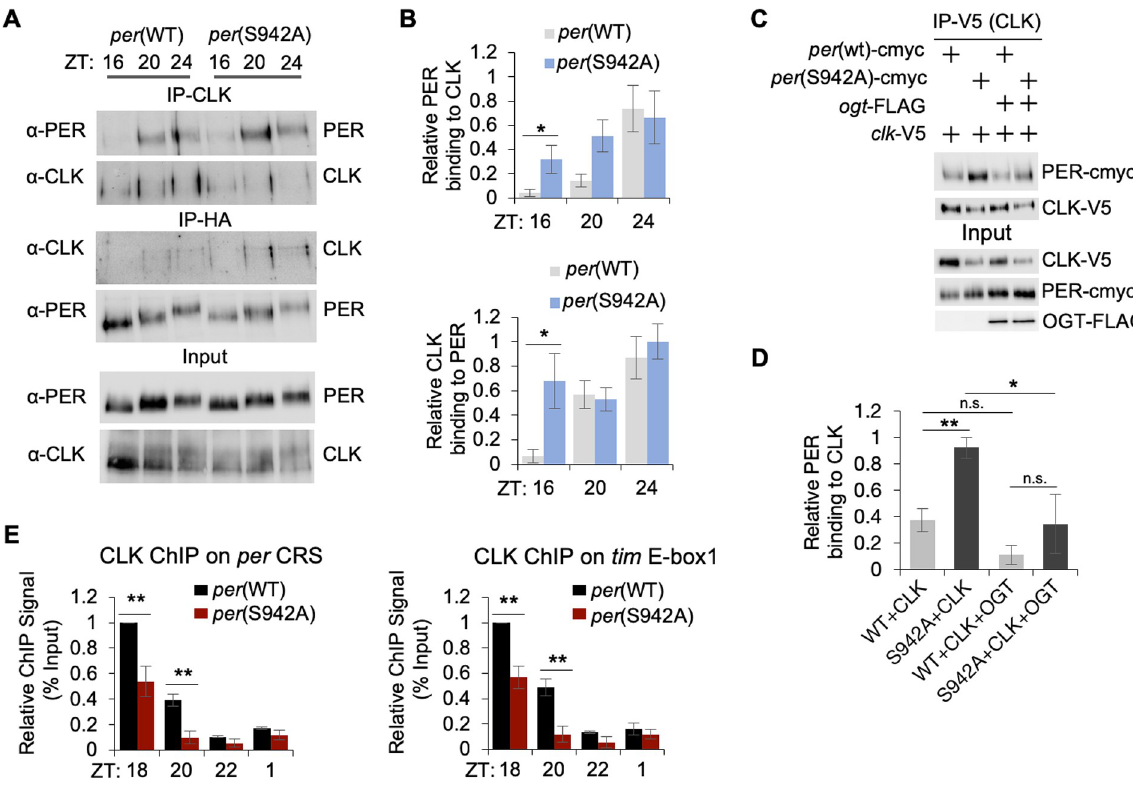
Fig 4. Non-O-GlcNAcylatable mutation at PER(S942) elevates PER repressor activity by increasing PER-CLK interaction and promoting CLK dissociation at circadian promoters. (A) Western blots showing reciprocal coimmunoprecipitations (coIPs) to examine PER-CLK binding in wper 0 ; p { per(WT)- HA10HIS} and wper 0 ; p { per(S942A)- HA10HIS} flies at the indicated time-points. Flies were entrained for 2 days in 12h:12h LD cycles and collected on LD3. Protein extracts from fly heads were directly analyzed (input) or immunoprecipitated with α -HA to detect PER-HA or α -CLK. Immune complexes were then subjected to immunoblotting to detect bait or interacting proteins. (B) Bar graphs showing quantification of reciprocal coIPs to examine PER-CLK binding from three biological replicates. Values for binding of interacting proteins are normalized to amount of bait detected in the IPs. Error bars indicate ± SEM. � P < 0.05. (C) Western blots showing results of coIP to evaluate PER-CLK interaction in S2 cells expressing pAc -per (WT)-6Xcmyc or pAc -per (S942A)-6Xcmyc with pAc -clk -V5 in the presence or absence of pMT -ogt -3XFLAG. Protein extracts from S2 cells were either directly analyzed by immunoblotting (input) or subjected to immunoprecipitation with α -V5 or resin conjugated with a non-specific antibody ( α -HA) as negative control (no signal detected). Immune complexes were analyzed by α -V5 to detect CLK-V5 protein (bait) or by α -cmyc to assess interaction with PER-cmyc. (D) Bar graph shows quantification of PER normalized to IP-V5 (bait protein, CLK) from four independent experiments. Error bars indicate ± SEM. � P -value = 0.05, �� P -value < 0.01. (E) ChIP assays using fly head extracts showing reduced CLK occupancy at per and tim promoters in wper 0 ; p { per(S942A )- HA10HIS} as compared to wper 0 ; p { per(WT)- HA10HIS} flies. Error bars indicate ± SEM (n = 3). � P -value < 0.05, �� P- value <